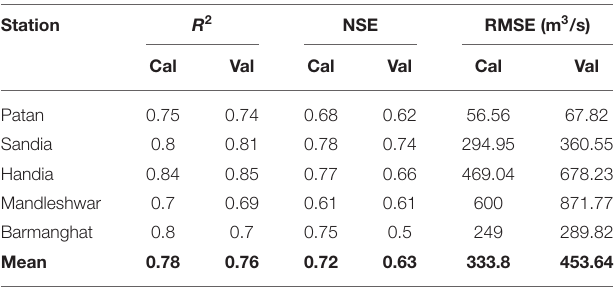
TABLE 4 | Calibrated SWAT parameter ranges for the Narmada River basin.